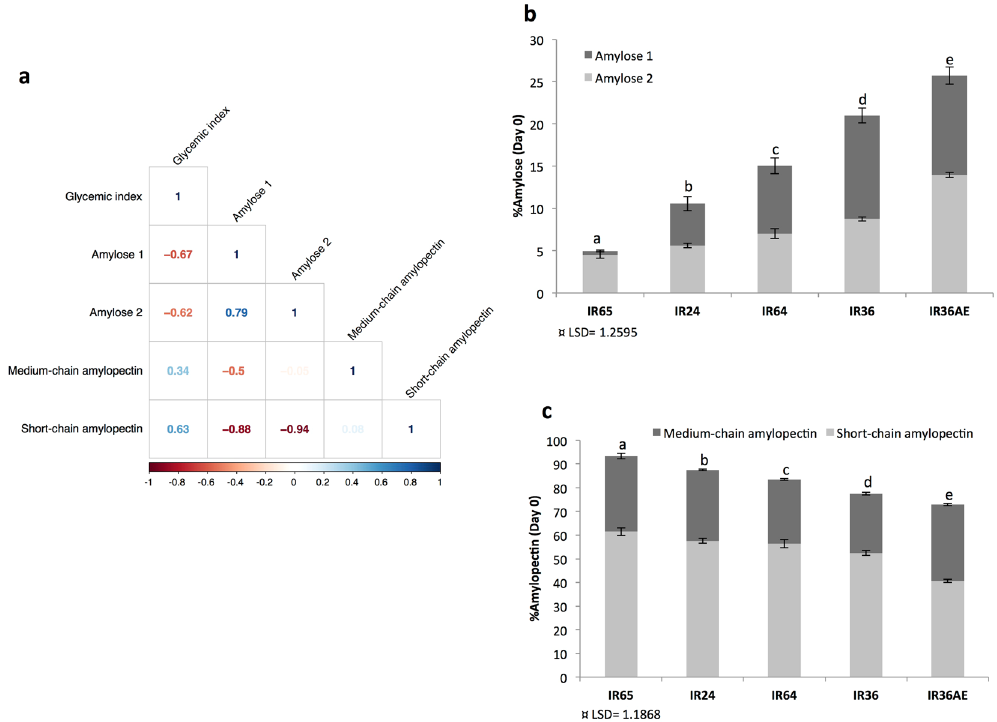
Figure 1. Glycemic index and starch regions. ( a ) Correlation between the starch regions in the mature grains of 27 breeding lines with estimated glycemic indeces and amounts of ( b ) amylose and ( c ) amylopectin fractions before the start of imbibition of five selected rice lines.